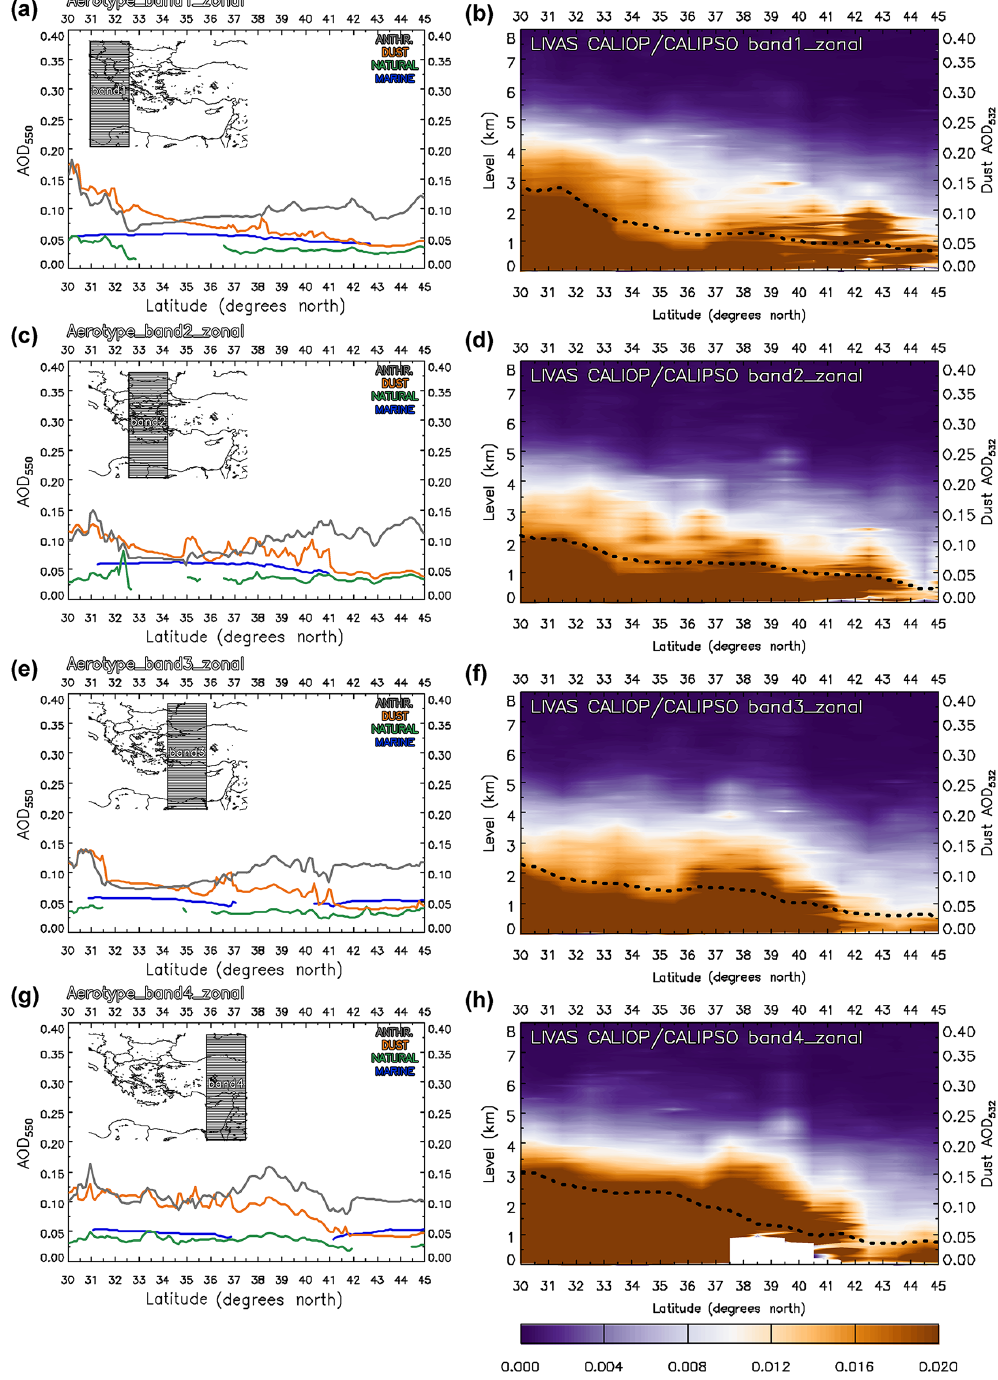
Figure 9. Left column: latitudinal variability of anthropogenic aerosols ( τ a ) , dust ( τ d ) , fine-mode natural aerosols ( τ n ) and marine aerosols ( τ m ) for four 5 ◦ longitudinal bands (see embedded maps), covering the Eastern Mediterranean based on MODIS Terra observations. Right column: latitudinal variability of dust extinction coefficients at 532nm in km − 1 (color scale corresponds to the extinction coefficients and left y axis to the atmospheric levels) and dust aerosol optical depth at 532nm (dotted line corresponding to the right y axis) for the same four bands from LIVAS CALIOP/CALIPSO